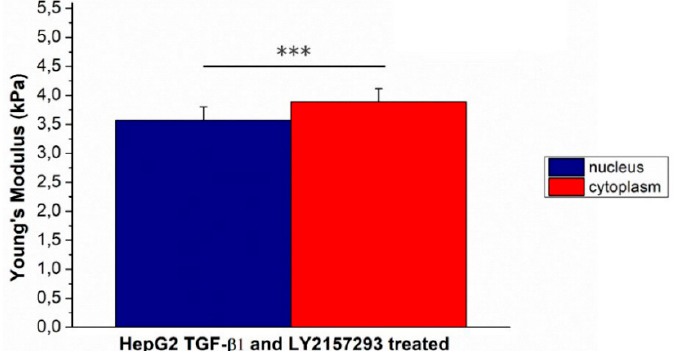
Figure 7. The Young’s modulus values with standard deviation, calculated from the nuclear region and the cytoskeletal area respectively, were reported for Galunisertib and TGF- β 1 concurrently treated HepG2 cells. Results were statistically significant for p < 0.005 (indicated as ***).